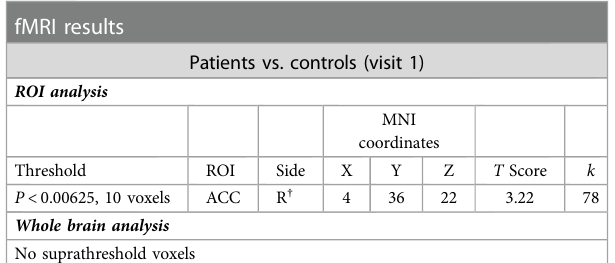
TABLE 5A Cluster of increased BOLD signal in controls, compared with patients (visit